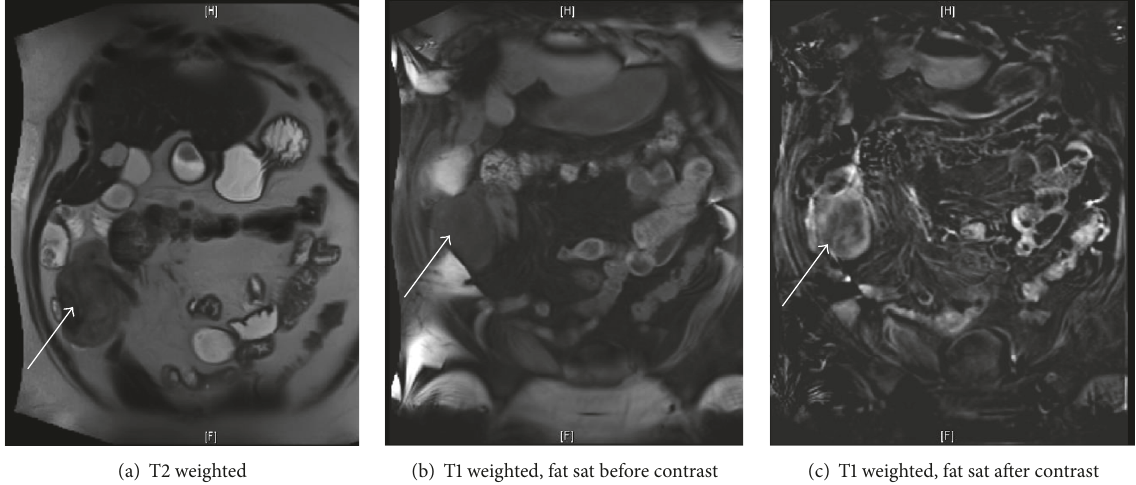
Figure 3: MRI T2 sequence (a), T1 unenhanced sequence (b), and T1 enhanced sequence (c), performed four months following most recent CT. This shows a solid mass (white arrow) of mixed signal intensity on T2, with mild enhancement, in the mesentery of the right lower quadrant that has increased in size from most recent CT.